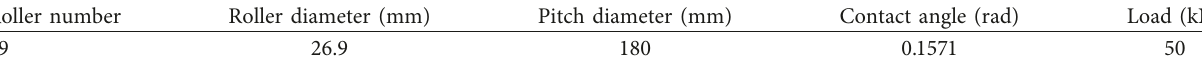
Table 2: The parameters of the tested wheelset bearing.